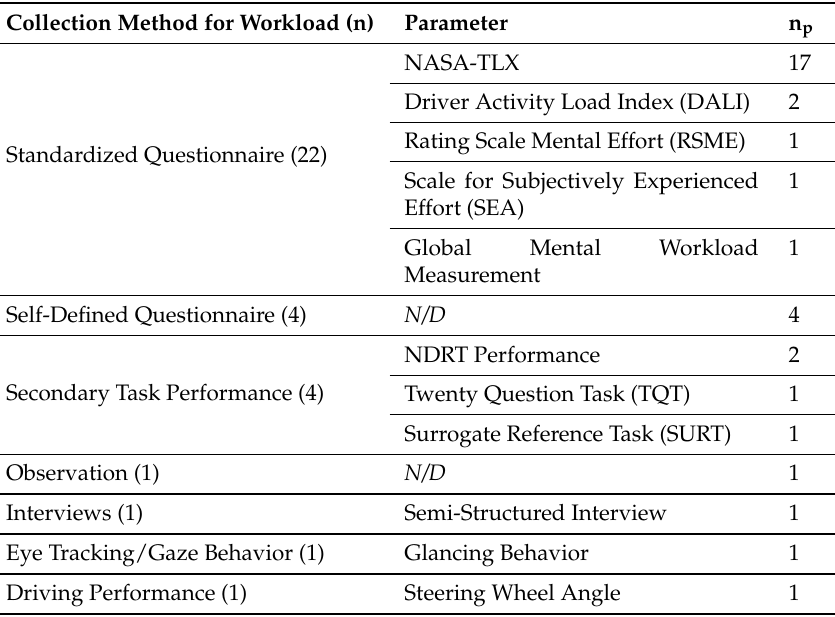
Table 5. Workload collection methods and